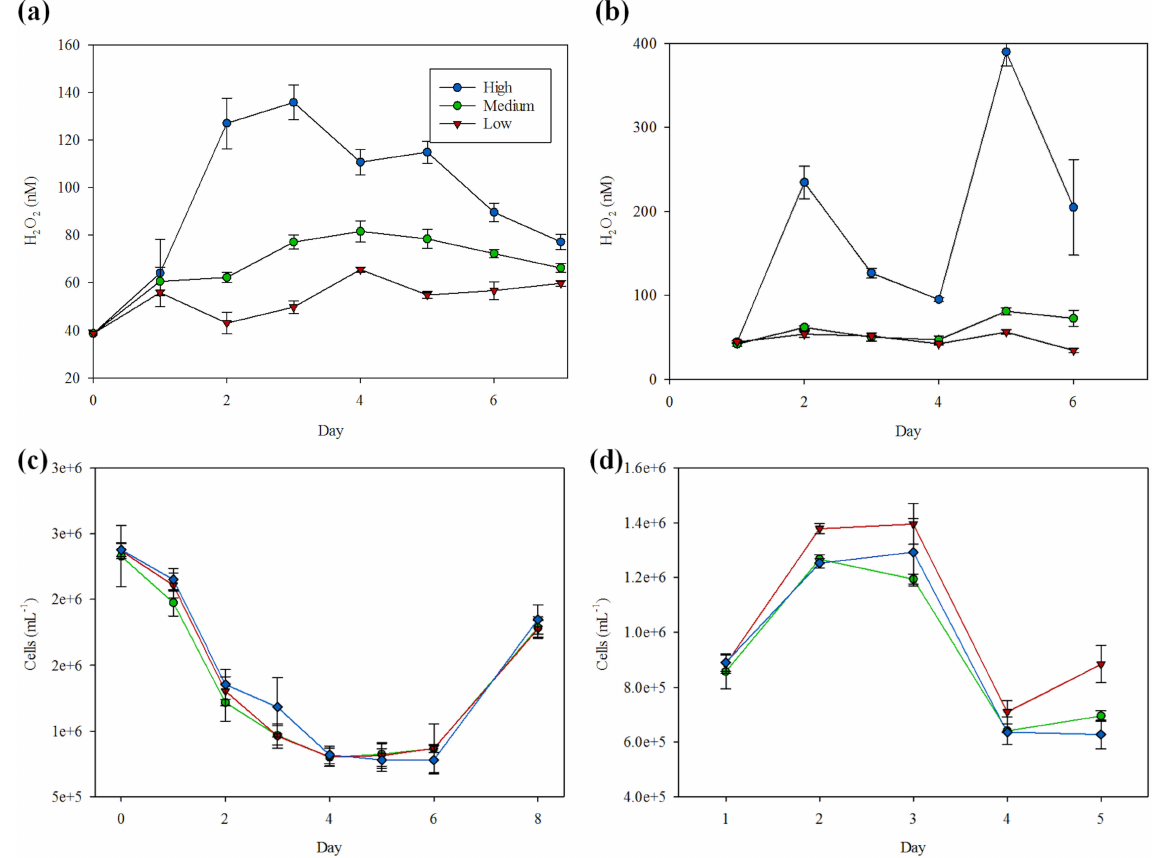
Figure 9. (a) H 2 O 2 gradient during the 20L scale Mediterranean side experiment where H 2 O 2 gradient was created with H 2 O 2 spikes and catalase. (b) H 2 O 2 gradient during the 20L scale Gran Canaria side experiment where a H 2 O 2 gradient was created with H 2 O 2 spikes. (c) Bacteria abundance during the Mediterranean experiment. (d) Bacteria abundance for the Gran Canaria experiment. Mean and standard deviations of triplicate treatments are plotted in all